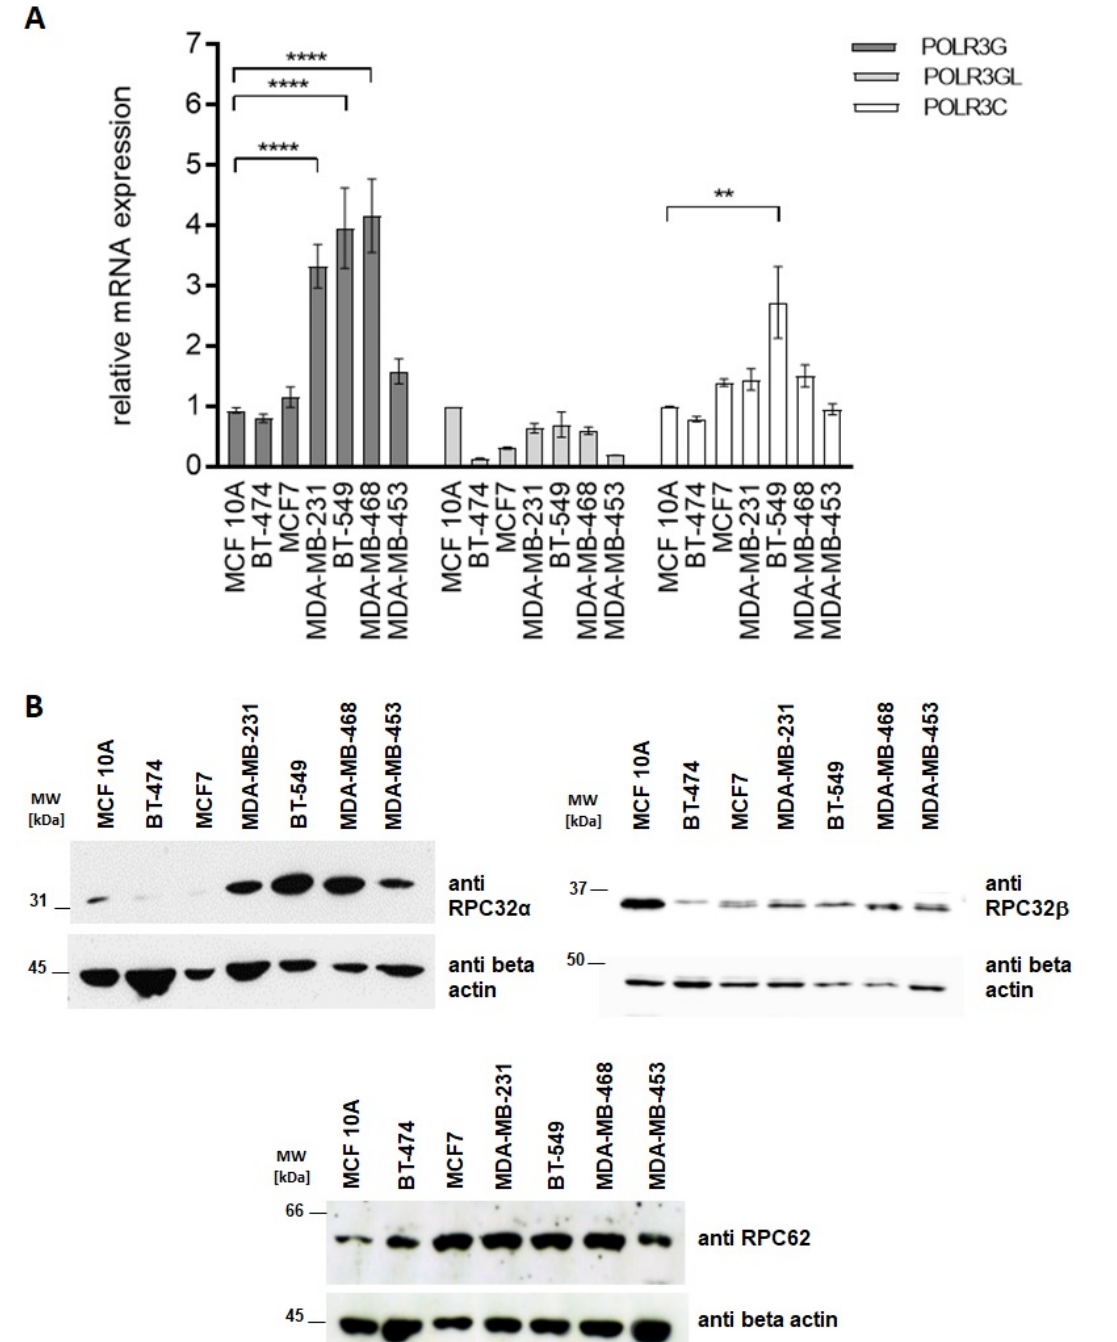
Figure 3. Analyses of Pol III subunit expression in breast cancer cell lines. ( A ) POLR3G mRNA is overexpressed in triple ‐ negative breast cancer cell lines. Determination of Pol III subunit mRNA levels by RT ‐ qPCR (Materials and Methods). Total RNAs were isolated from different breast cancer cell lines and compared with the non ‐ tumorigenic control MCF10A cell line. Analyzed cell lines are appropriately depicted below the graphs. The code for analyzed genes is shown to the upper right. Relative mean expression of three independent experiments ± SEM (** p < 0.01, and **** p < 0.0001) is shown. ( B ) RPC32 α protein is overexpressed in triple ‐ negative breast cancer cell lines and RPC32 β in the non ‐ tumorigenic cell line. Western blot (Materials and Methods) with anti-RPC32 α , -RPC32 β and -beta-actin antibodies. Analyzed cell lines are appropriately depicted above the ECL images. The uncropped Western Blot images of Figure 3 can be found in Figure